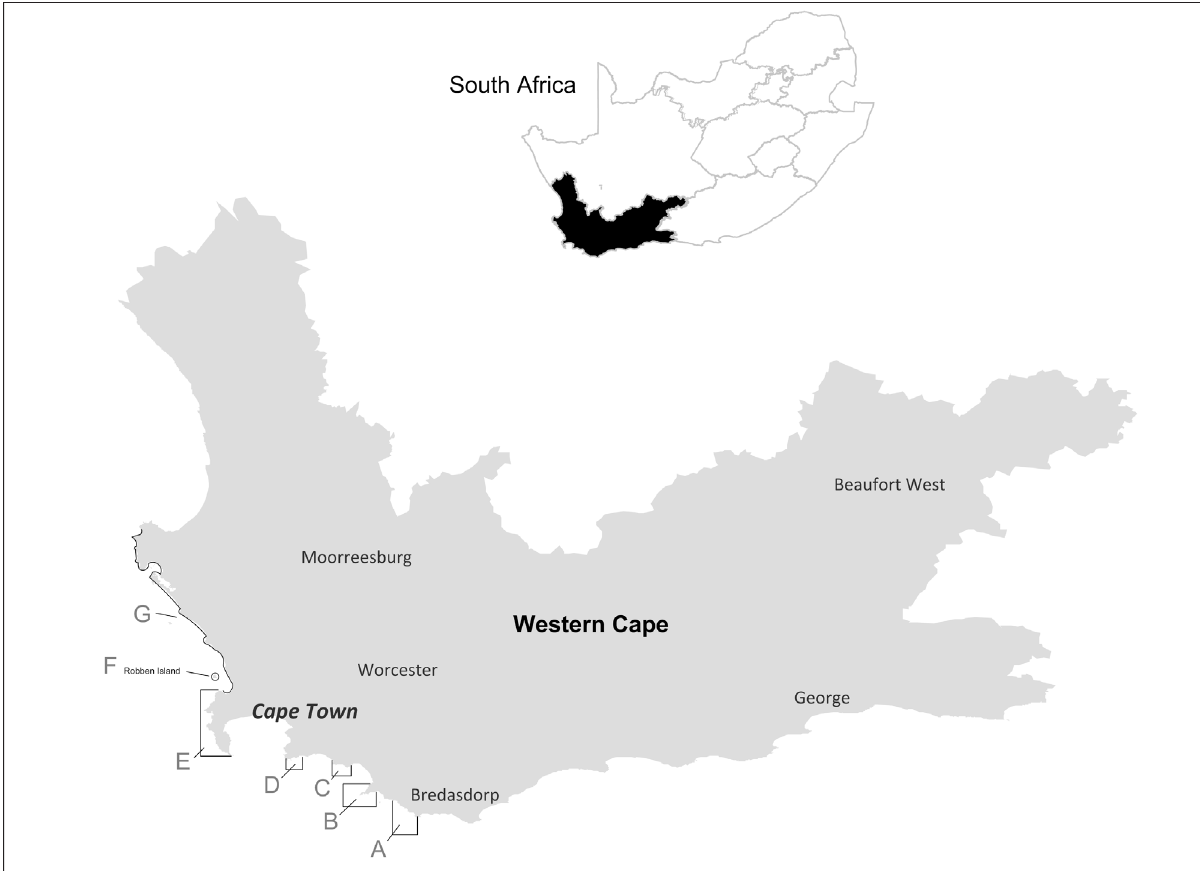
Figure 1: Map of the study site, showing Zone E within the context of other abalone fishing zones in the Western Cape Province of South